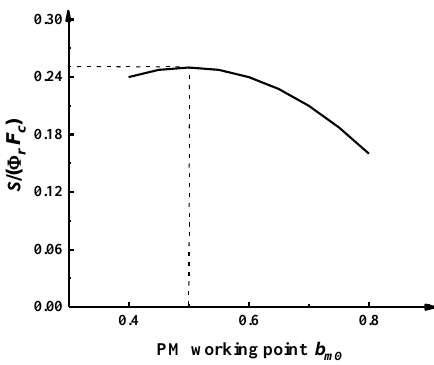
Figure 4. Relative value change of the effective magnetic energy for different PM working point.